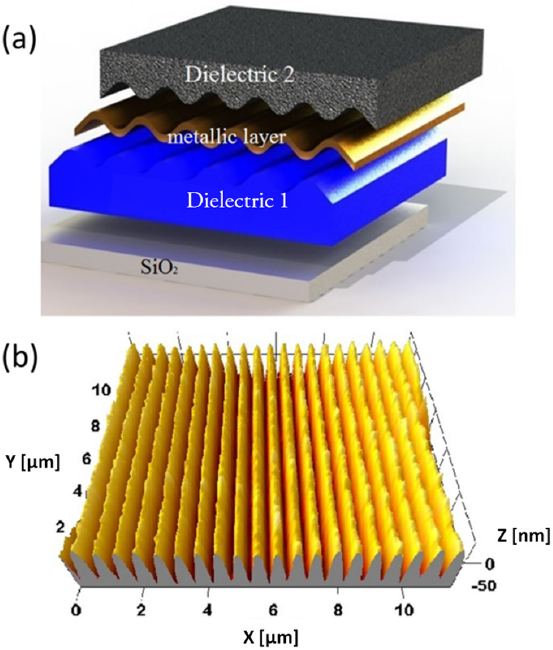
Figure 1. ( a ) sketch of the plasmonic crystal multilayer profile; it is formed by the SiO 2 glass substrate, the phenyl ‐ bridged silsesquioxanes (ph ‐ PSQ) films with the patterned grating (dielectric 1) and the gold layer. On top of th metallic layer it is possible to deposit a sensitive film (dielectric 2) that can be TiO 2 or SiO 2 as described in the text. ( b ) three ‐ dimensional Atomic Force Microscopy (AFM) reconstruction of the grating surface, before the deposition of dielectric 2.